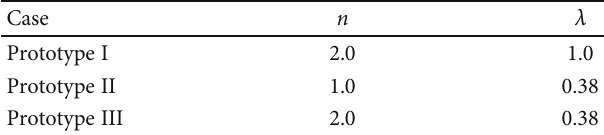
Table 1: Scale factors of the prototypes.